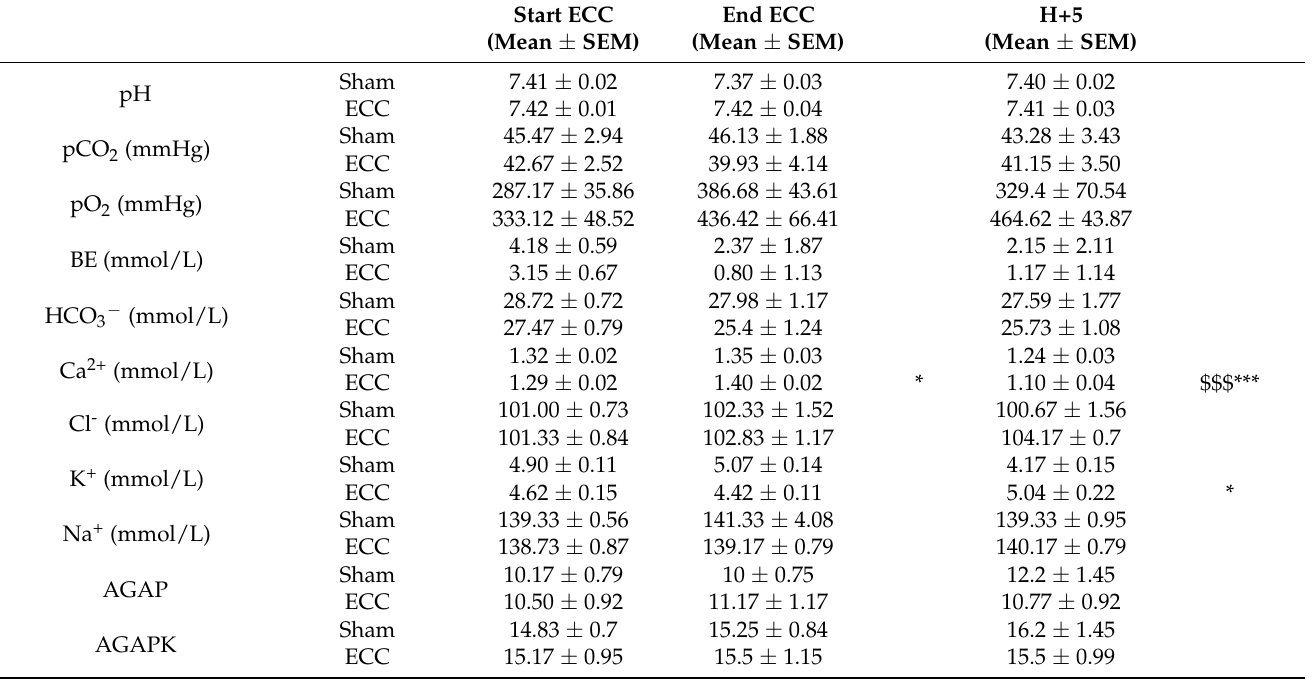
Table 1. Point-of-care measure of blood gases and electrolytes on arterial blood from the rat model.